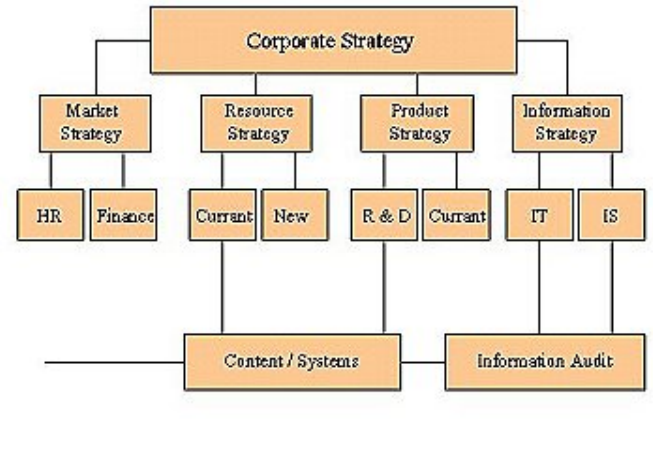
Figure 1 Information audit in